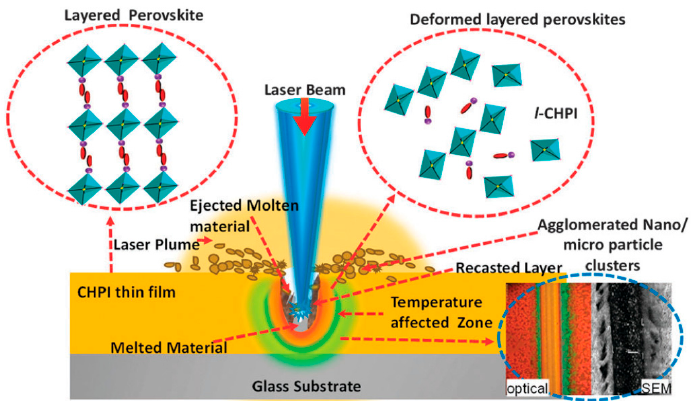
Figure 4. Schematic of the laser-material interaction during perovskite laser micropatterning and PeNCs formation. Reproduced with permission from [48]. © Royal Society of Chemistry.